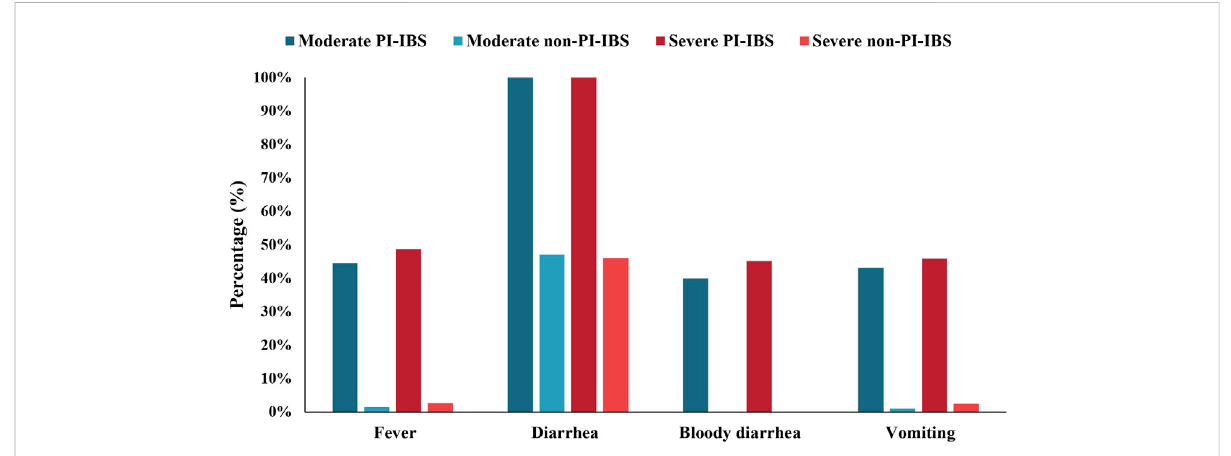
FIGURE 7 Initial symptoms of participants with PI-IBS and non-PI-IBS strati fi ed by moderate and severe